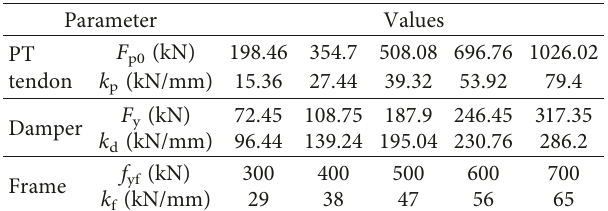
Table 2: Parameter values used in the